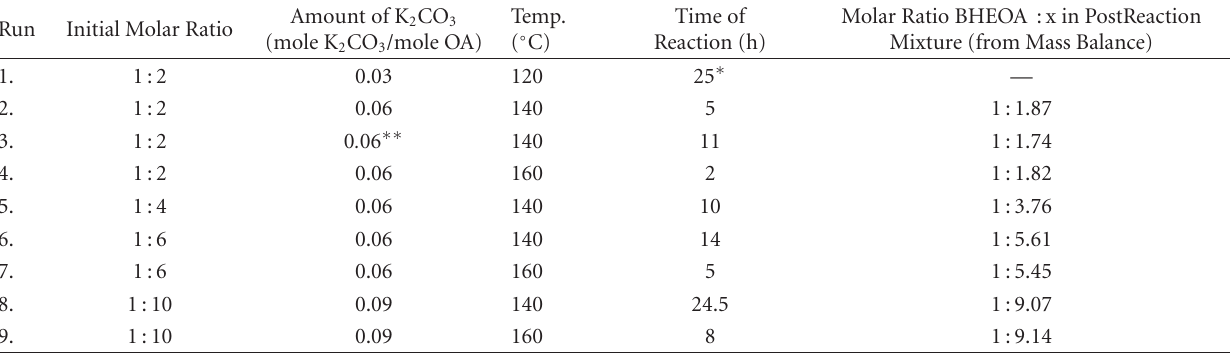
Table 1: Reaction conditions of BHEOA with EC.